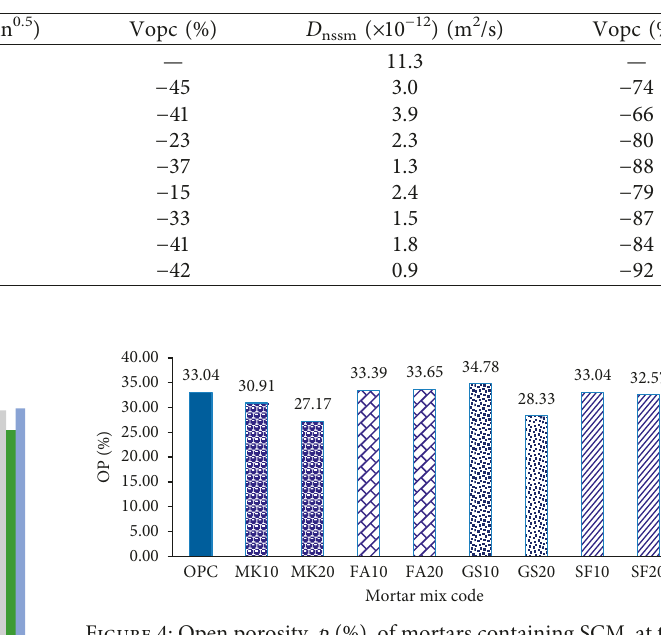
Figure 4: Open porosity, p (%), of mortars containing SCM, at the age of 28 days.